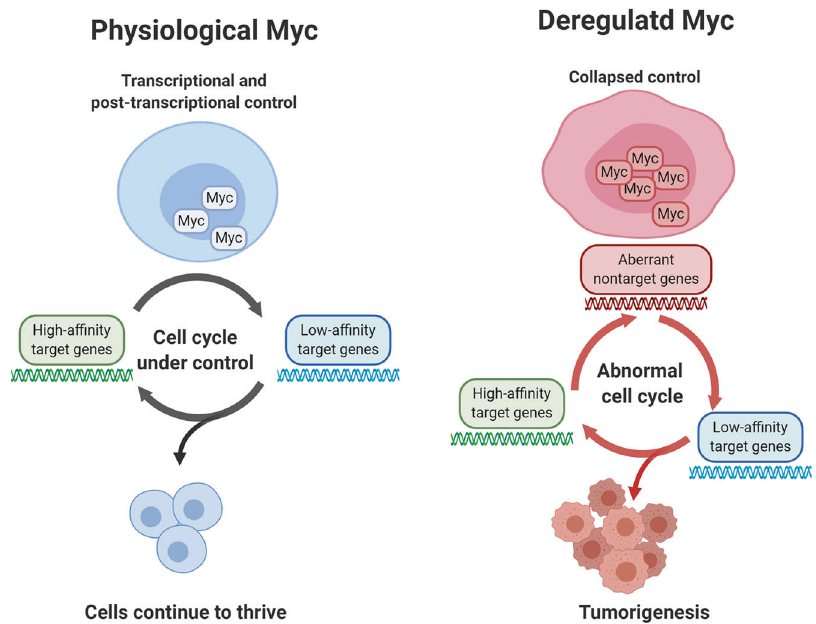
Fig. 2 Comparison between physiological Myc and deregulated Myc. The collapsed control of Myc intensi fi es the expression of both target genes as well as additional aberrant nontarget genes, thereby enhancing tumorigenesis. In the physiological state, Myc is tightly controlled by transcriptional as well as post-transcriptional components. High-af fi nity target genes, with expression independent of the Myc level and cell types, actively respond to Myc, while low-af fi nity target genes respond at a low level. The integrated signals from these two target genes facilitate the cells to thrive. Decontrolled Myc increases the expression of both high- and low- af fi nity target genes; also, additional nontarget genes might be activated. These three signals lead to further tumorigenesis driver gene in multiple human cancers, this oncoprotein has been listed on the top of the putative drug target list. Despite the long pursuit of inhibitors for Myc, there is a dearth of information, and directly targeting the Myc oncoprotein is yet challenging. Brie fl y, two major problems need to be considered. expression of Myc protein is strongly correlated with cell proliferation. Although the inhibition of Myc induces tumor Signal Transduction and Targeted Therapy (2021)